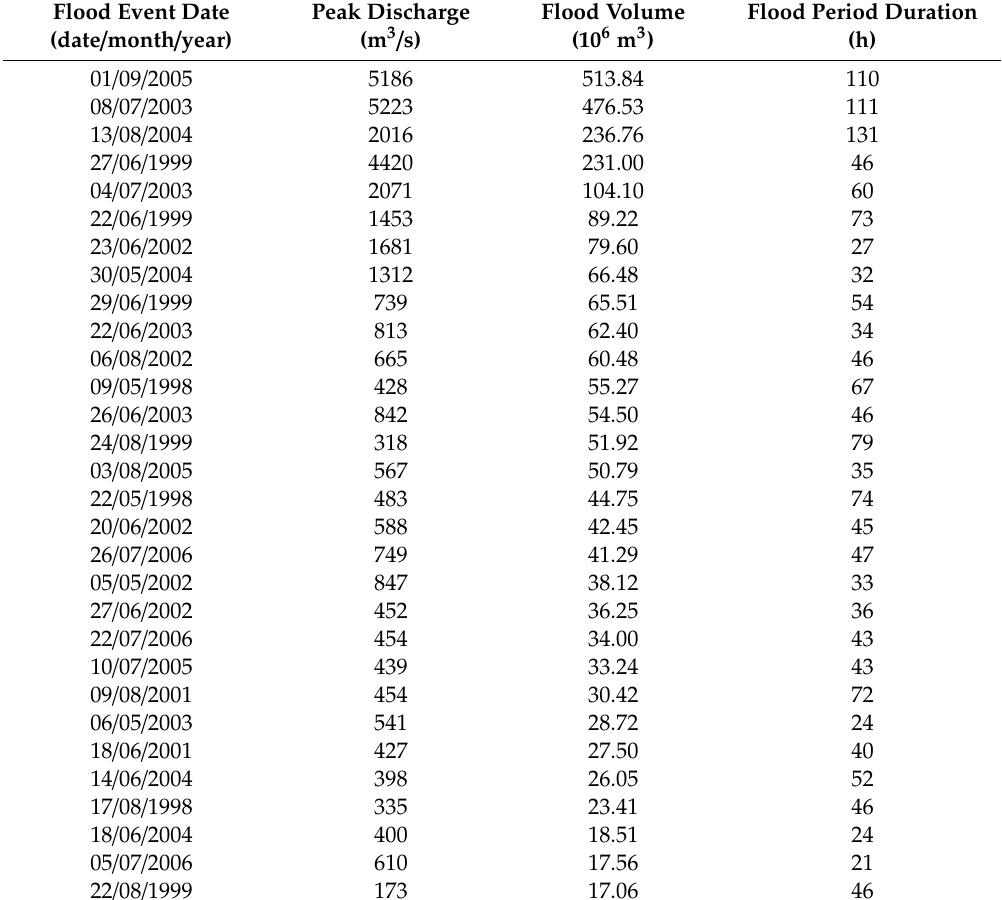
Table 1. Historical floods of Xianghongdian